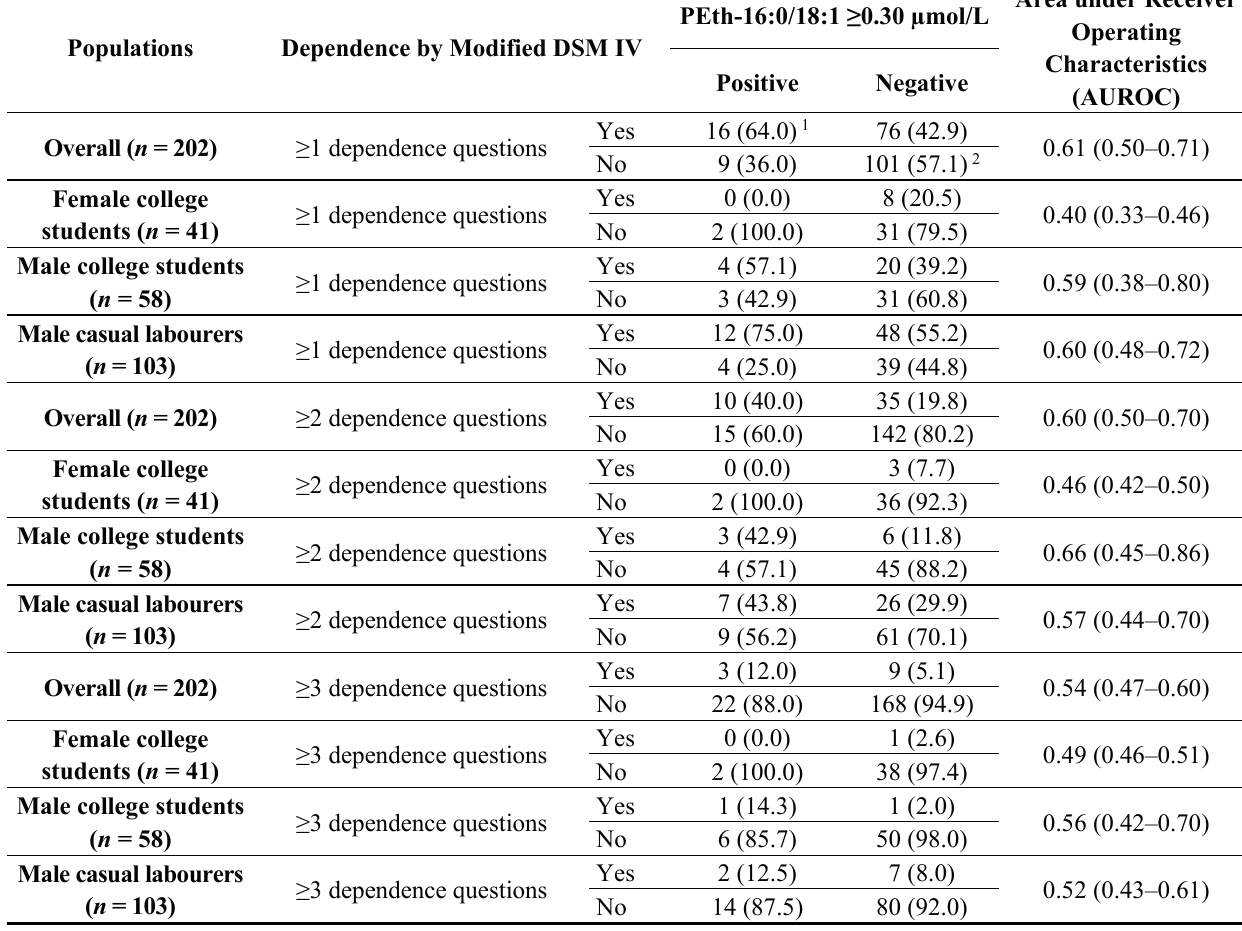
Table 4. Sensitivity and specificity of modified MINI results compared with PEth